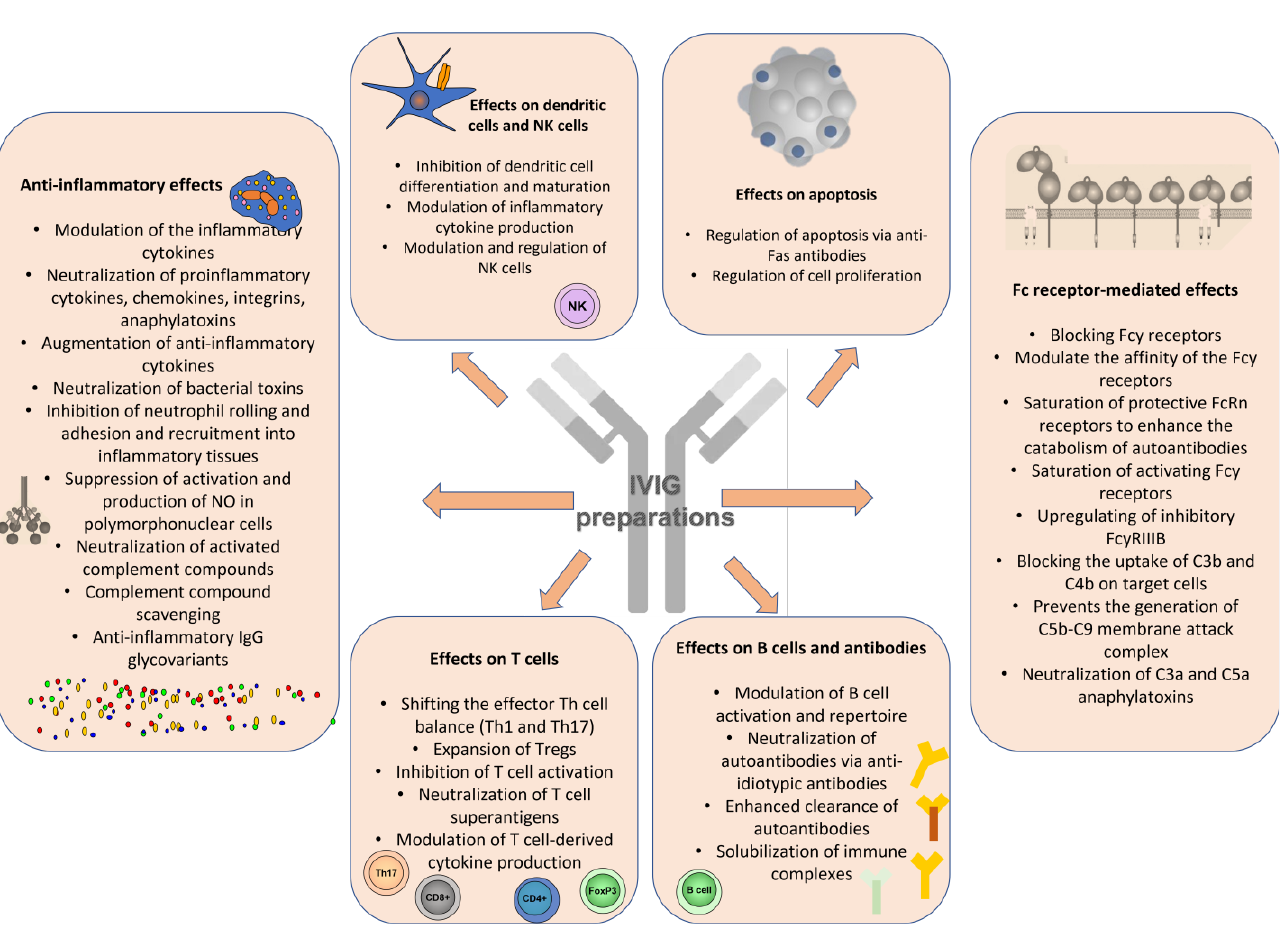
Figure 1. Immune mechanisms exerted by IVIG